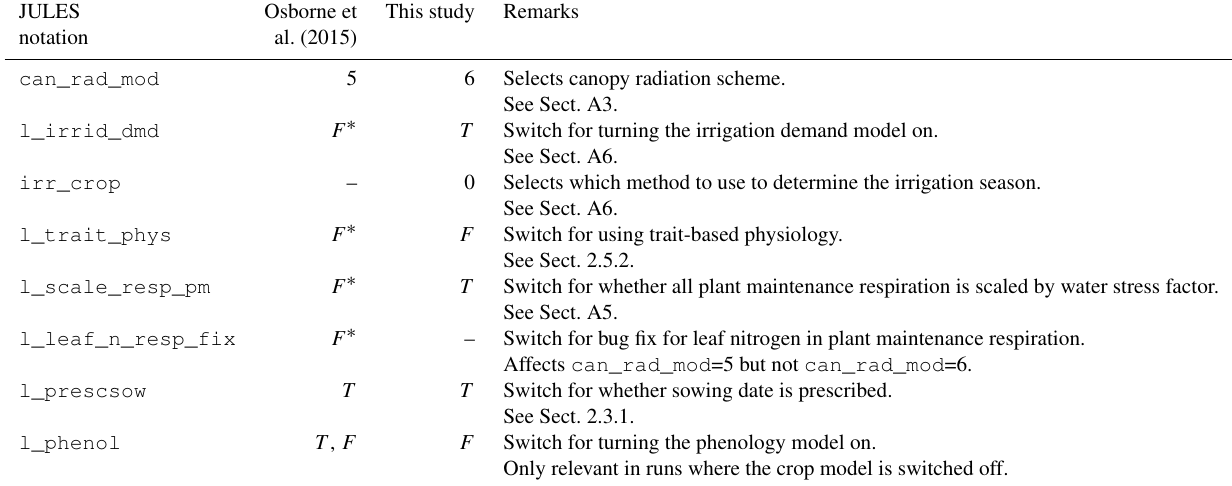
Table 1. JULES flags relevant to this study. These parameters are all specified in the JULES_VEGETATION namelist. JULES Osborne et This study